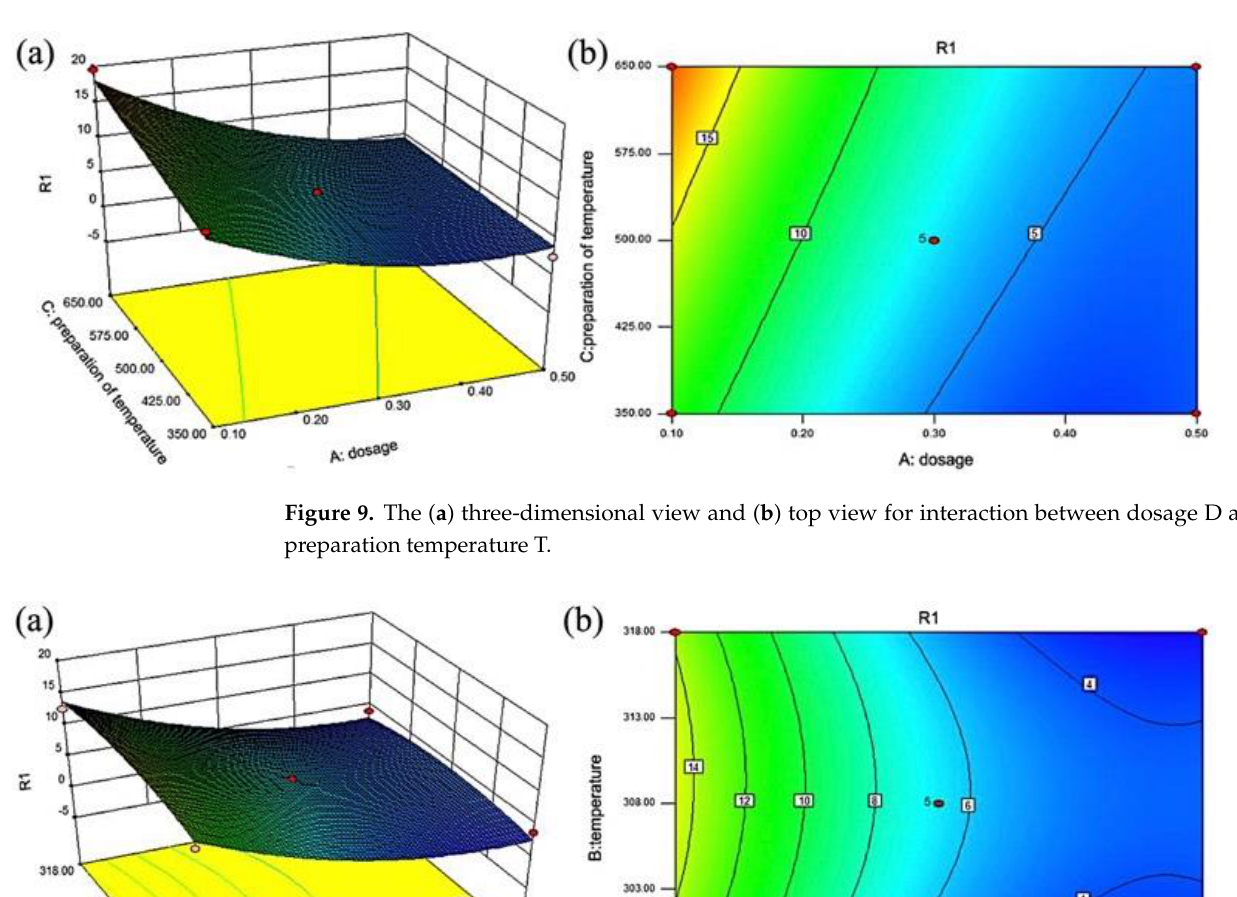
Figure 8. The ( a ) three-dimensional view and ( b ) top view for interaction between experimental temperature and preparation temperature T.